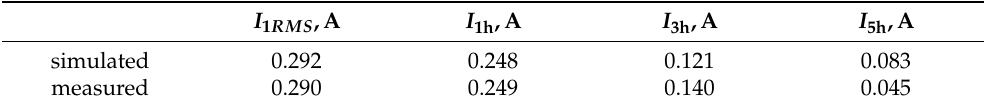
Table 2. Harmonic content of the steady-state current of the unloaded transformer from measure- ments and